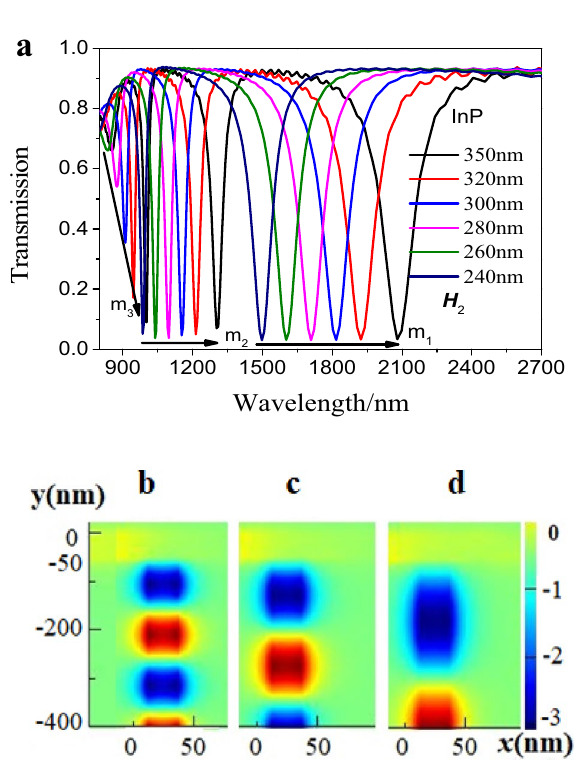
Figure 2. ( a ) The relation between Fano resonance and the height H 2 . ( b – d ) Magnetic field distribution of different modes at different resonance wavelengths 998 nm, 1302 nm and 2079 nm, respectively. Red and blue represent two different vibrations. The structural parameter was H 2 = 350